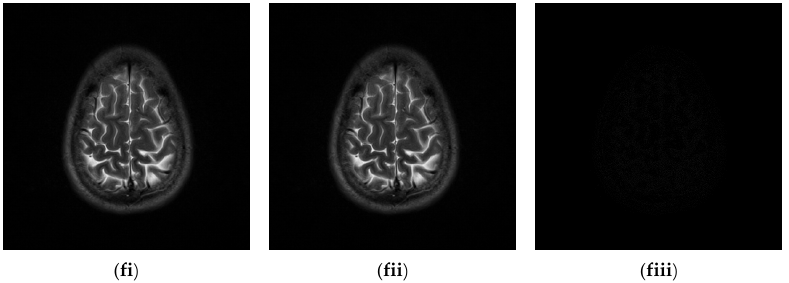
Figure 11. The original images, the confidential images, and the different images; ( ai,bi,ci,di,ei , fi ) The cover images; ( aii,bii,cii,dii,eii , fii ) The confidential images; ( aiii,biii,ciii,diii,eiii , fiii ) The difference between the cover images and the confidential images.